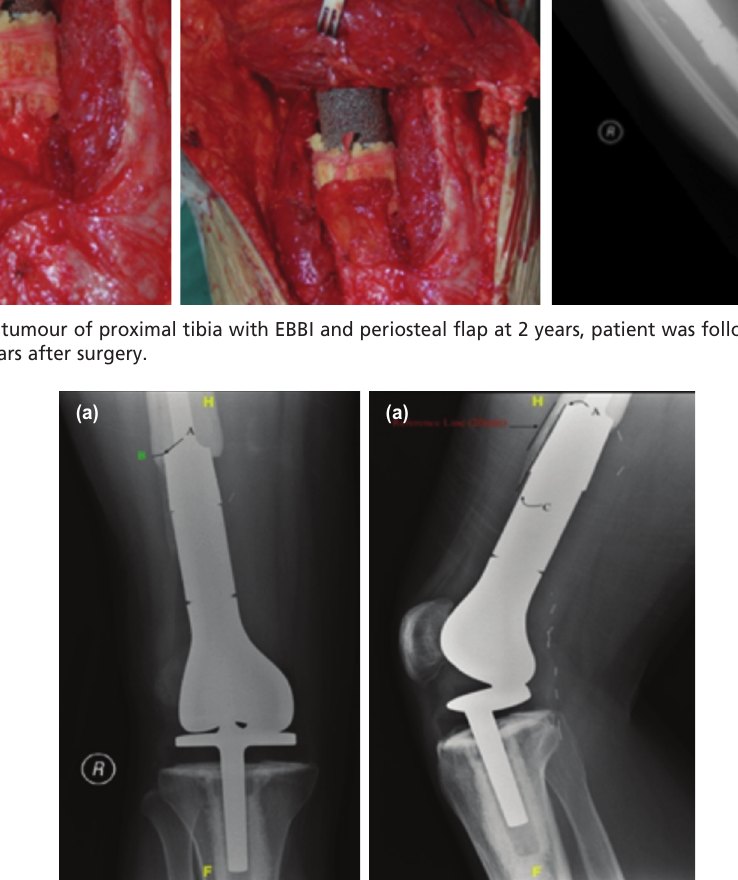
Measurement of thickness and length of extracortical bone bridge interface. (a) Antero-posterior radiograph of Knee joint Fig. 3: shows measurement of EBBI thickness (Point A to Point B). (b) Lateral radiograph of Knee joint shows measurement of EBBI Length (Point A to Point C).